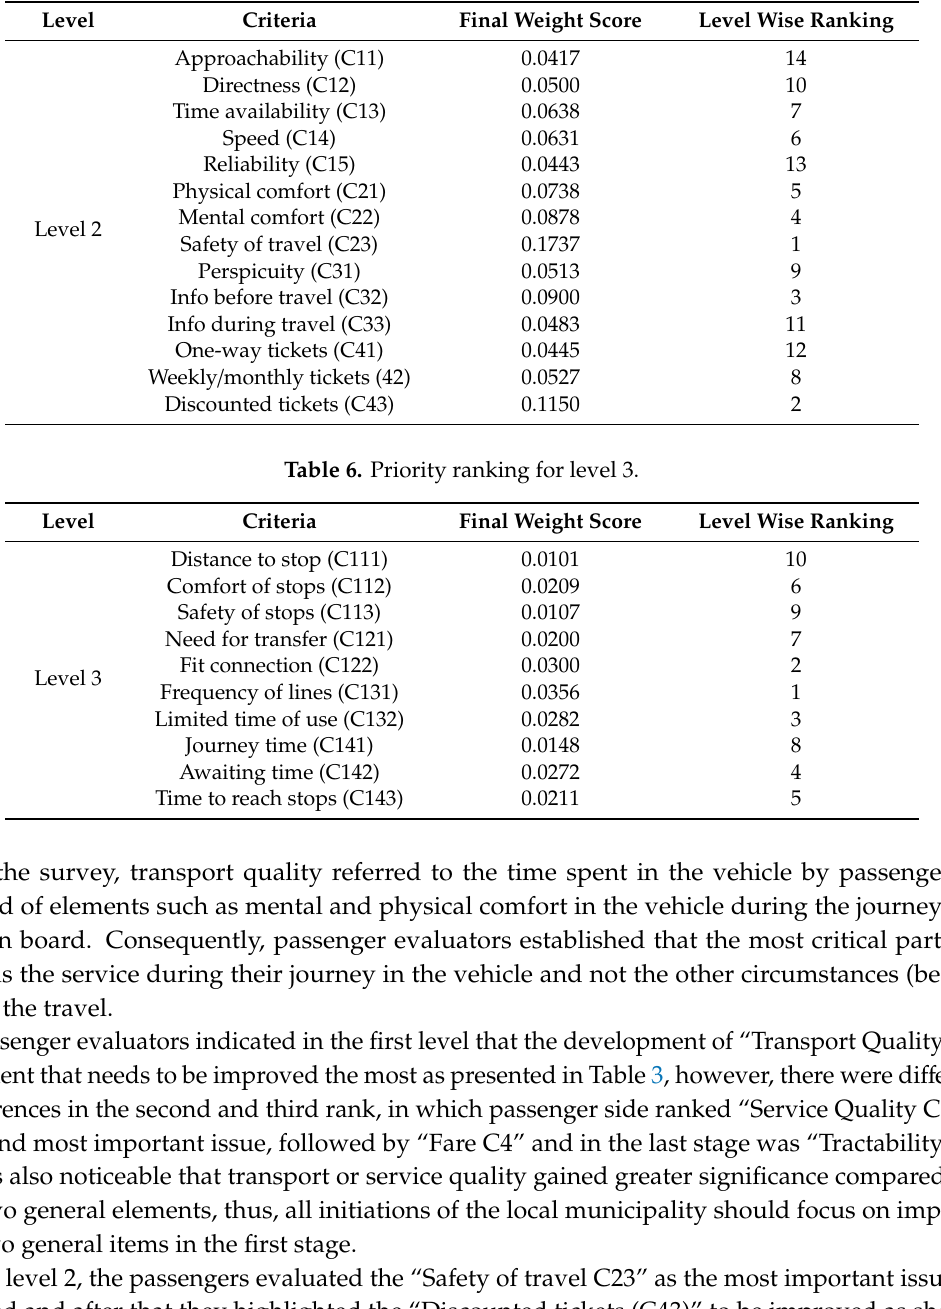
Table 5. Priority ranking for level 2.